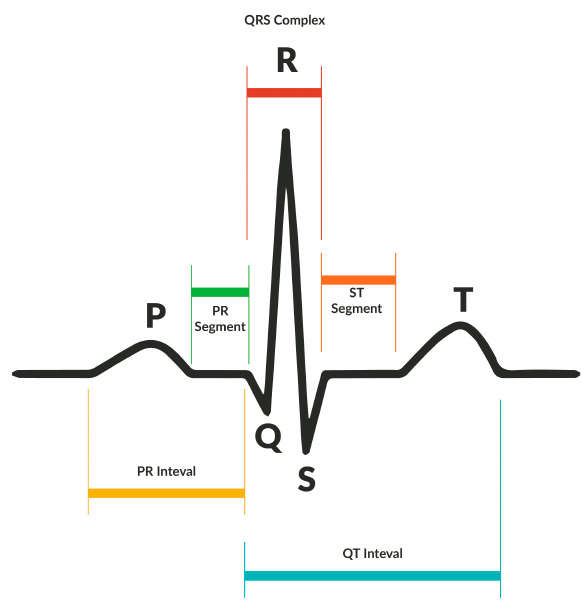
Figure 11. QRS Complex.